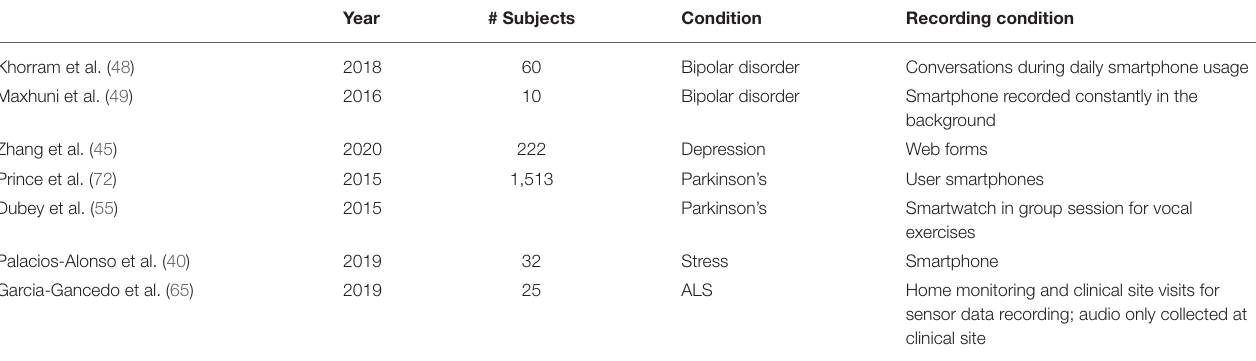
TABLE 3 | Included studies with original datasets, in which data was collected outside a traditional laboratory setup: in everyday